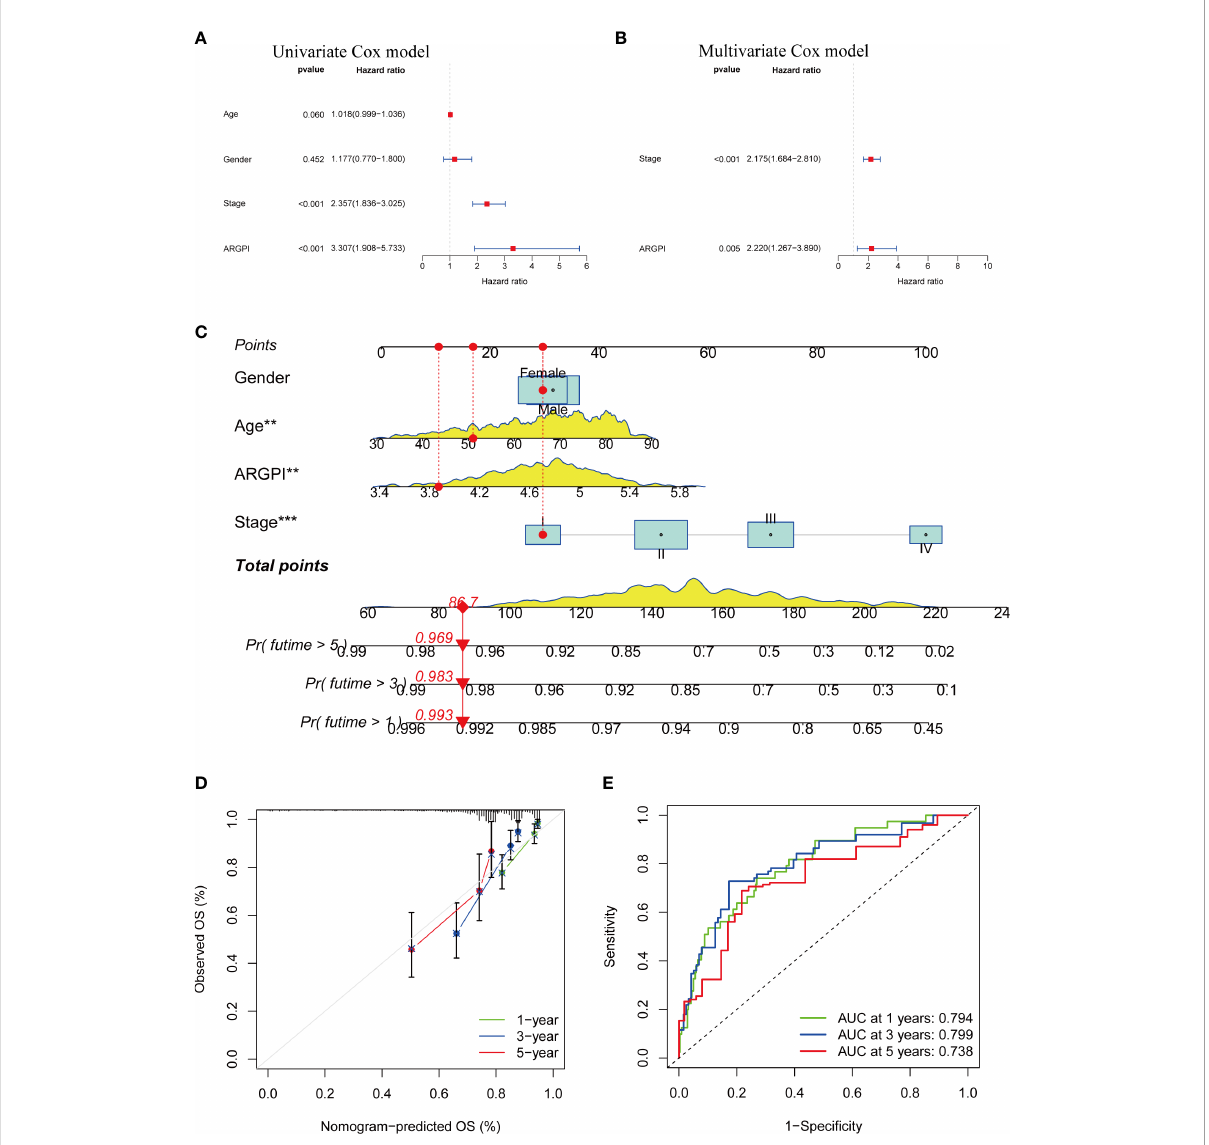
FIGURE 3 Construction of a nomogram. (A, B) Univariate and multivariate Cox analysis of clinicopathological factors and ARGPI in TCGA-COAD Cohort. (C) A nomogram based on ARGPI and clinicopathological factors to indicate OS in COAD patients. (D, E) Calibration curves and ROC curves were used to assess the robustness and accuracy of nomograms in predicting 1-, 3-, and 5-year OS in COAD patients. ** p < 0.01, and *** p <